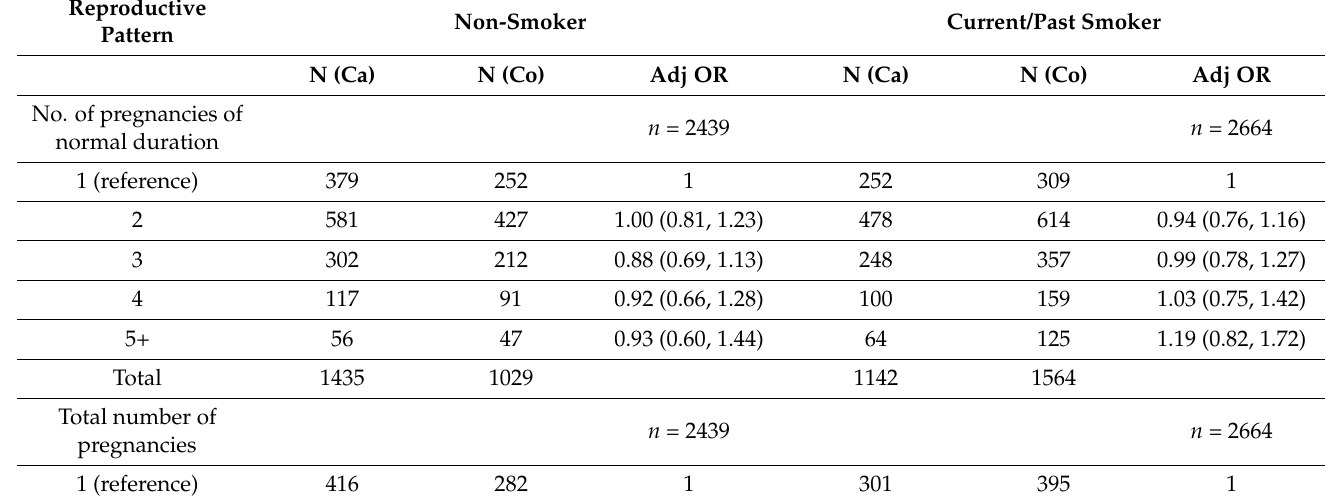
Table 5. Subgroup analyses including only those with known smoking status: reproductive variables by case-control status. Reproductive